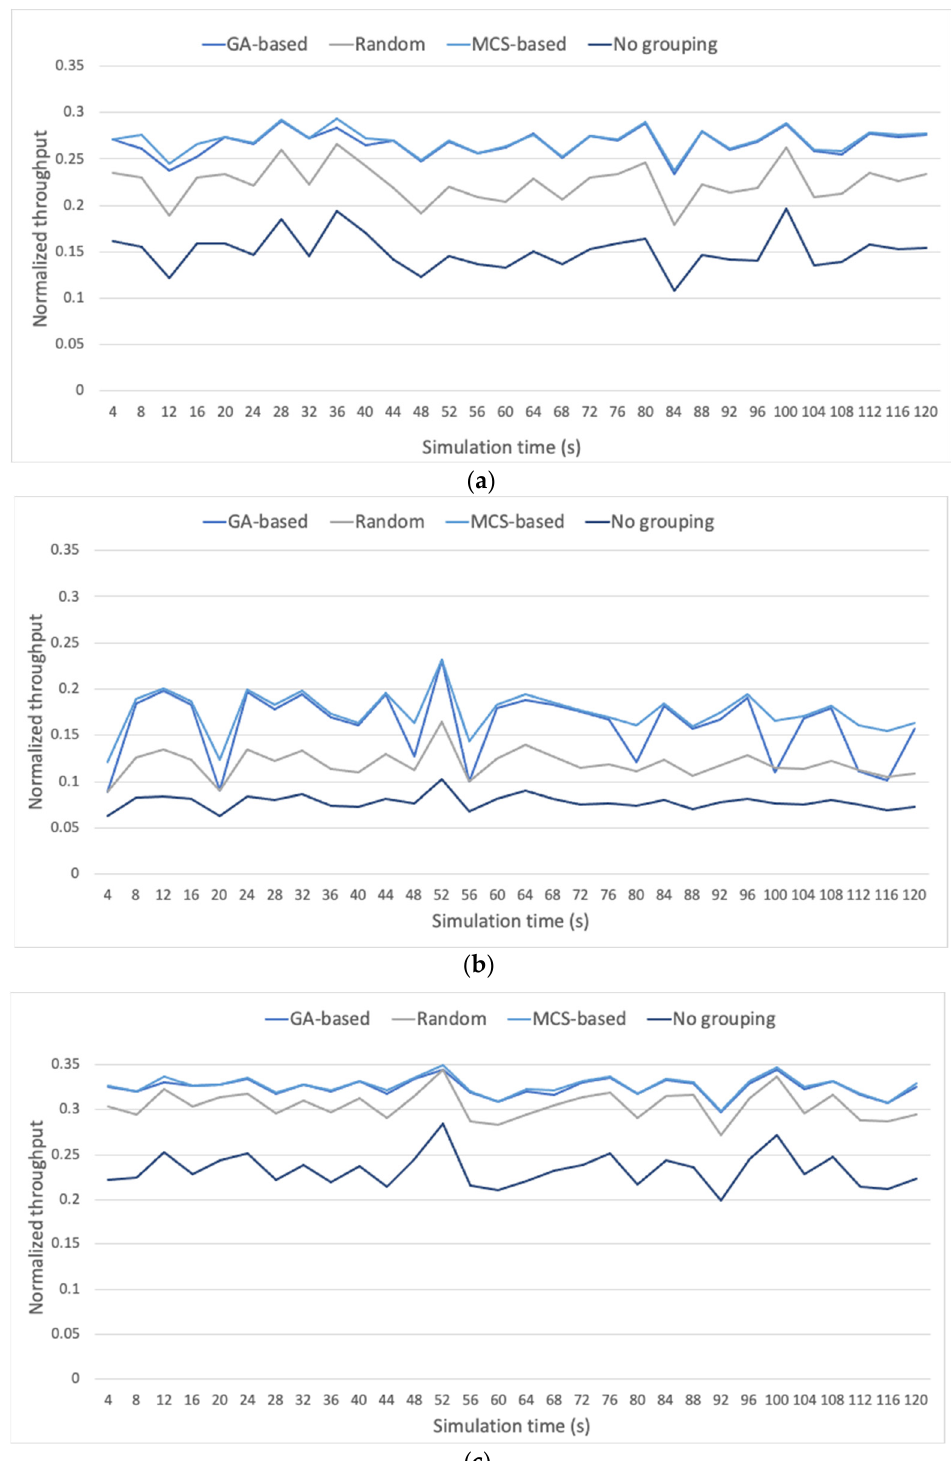
Figure 21. Throughput performance for scenario with STAs with ( a ) MCSs uniformly distributed, ( b ) MCSs distributed with 50% probability of being the slowest MCS (i.e., MCS 10), and 50% prob- ability of being any of the remaining MCSs (MCS 0 to MCS 9), and ( c ) MCSs distributed with 50% probability of being the fastest MCS (i.e., MCS 9), and 50% probability of being any of the remaining MCSs.